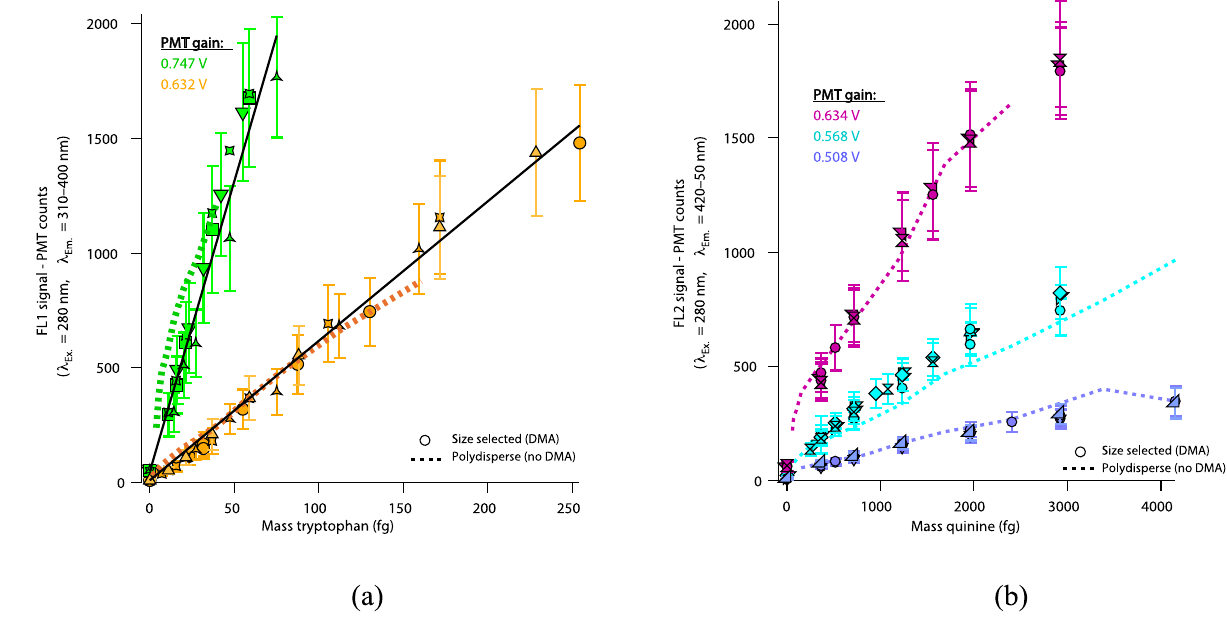
Figure 4. Fluorescence calibration curves for the FL1 (a) and FL2 (b) detectors for different PMT detector gains. The FL1 and FL2 detectors are calibrated with mixed tryptophan–ammonium sulfate and pure quinine particles, respectively. Each data point represents the central value of a Gaussian function fit to fluorescence signals at a given particle mass, while the error bars are the standard deviation in fluorescence signals for that mass. Each symbol shape refers to data from an individual calibration experiment to show repeatability. Dotted lines show results from polydisperse, fluorescent aerosol calibration experiments. Black lines in (a) are linear fits to the monodisperse